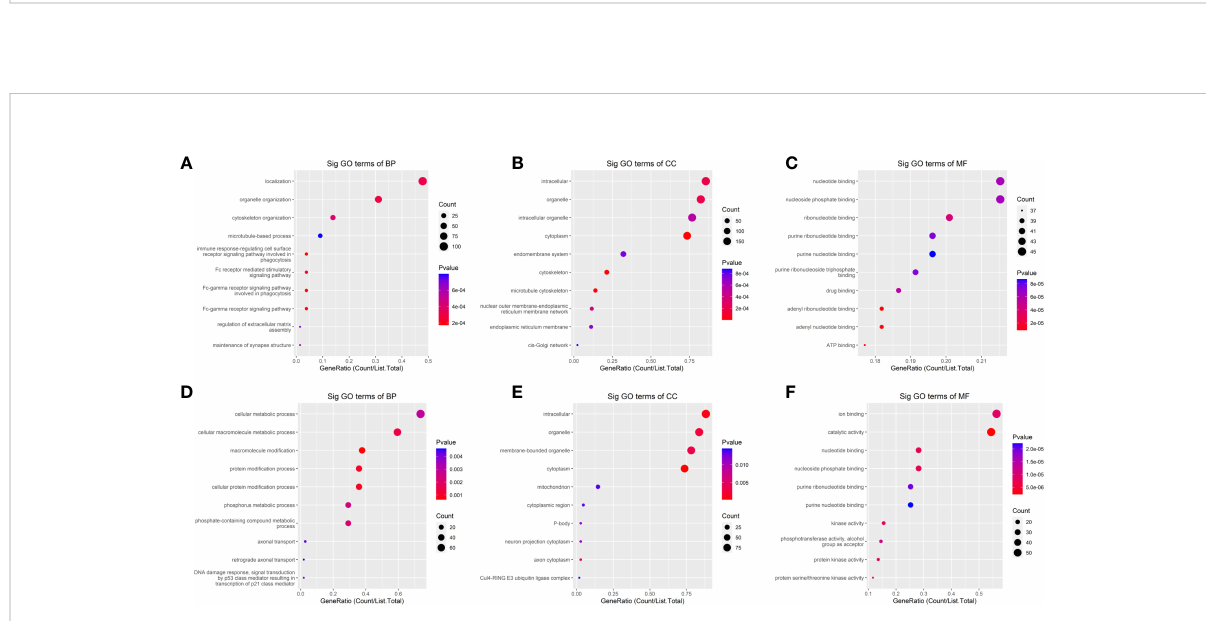
FIGURE 4 The Gene ontology (GO)-term enrichment analysis of signi fi cantly altered m 6 A-modi fi ed circRNAs between the in situ and the peritoneal metastasis lesions of the HGSCO patients. (A – C) upregulation of m 6 A-modi fi ed circRNAs. (D – F) downregulation of m 6 A-modi fi ed circRNAs.